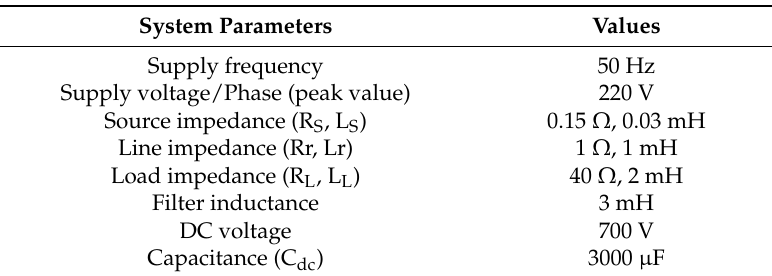
Table 2. Design parameters used for the simulation work.